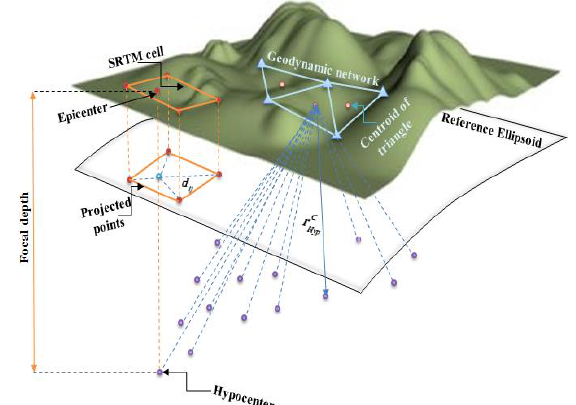
Figure 3. Calculation of seismogenic thickness. The red dots are the vertices of the SRTM cell around the earthquake epicenter. The geodetic height of the hypocenter is calculated by using the geodetic heights of the SRTM points and the focal